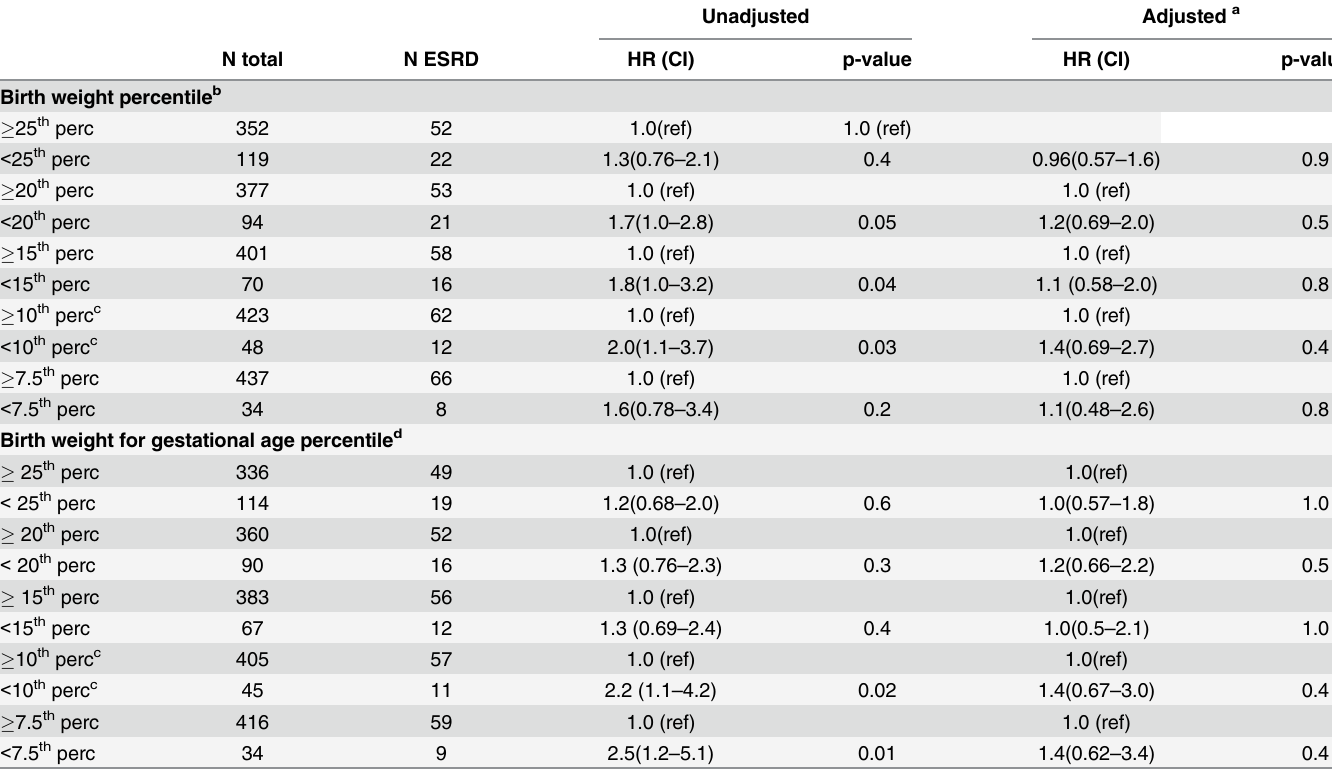
Table 3. Risk of ESRD among IgAN patients analysed at different percentile cut-offs for birth weight and birth weight for gestational age. Unadjusted Adjusted a N total N ESRD HR (CI) p-value HR (CI) p-value Birth weight percentile